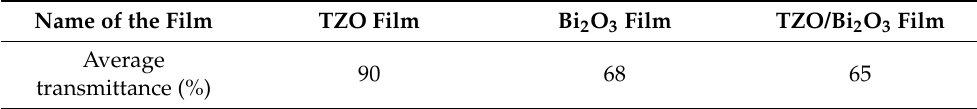
Figure 5. Optical transmittance spectra of each layer of TZO/Bi 2 O 3 heterojunction film. Table 4. Average optical transmittances of each layer of TZO/Bi 2 O 3 heterojunction film (380–780 nm).